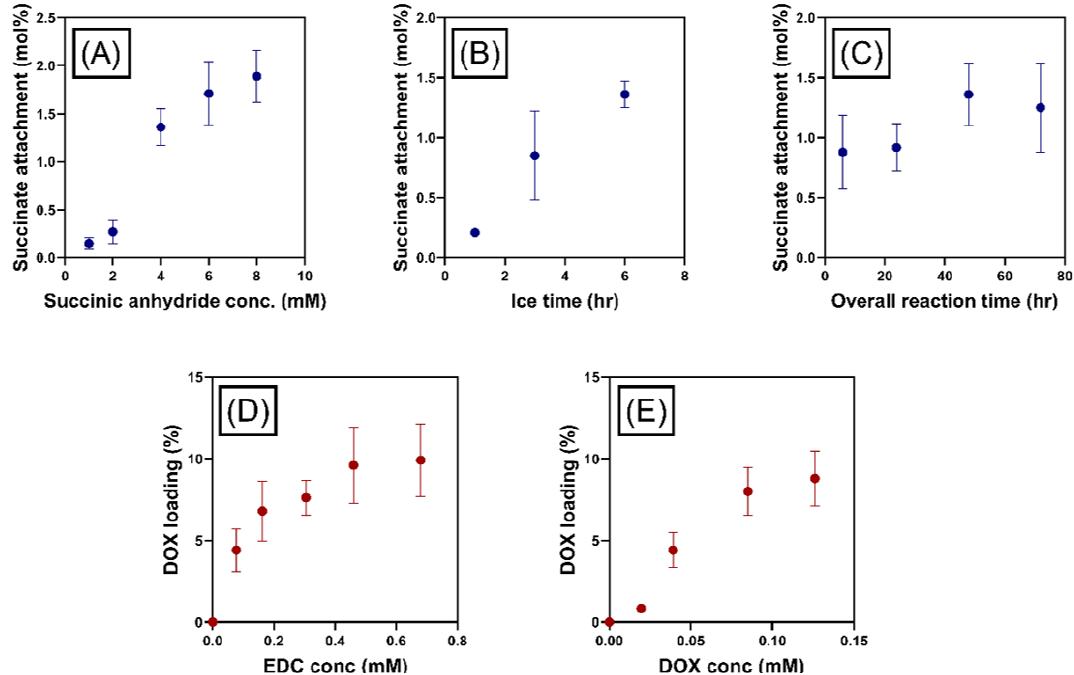
Figure 3. The number of succinate groups attached (mol%) as a function of: ( A ) Succinic anhydride concentration, ( B ) reaction time at 0 °C, and ( C ) overall reaction time. The reaction times used were: 6 h at 0 °C, 48 h reaction time. The doxorubicin loading (%) as a function of ( D ) EDC concentration and ( E ) doxorubicin concentration.